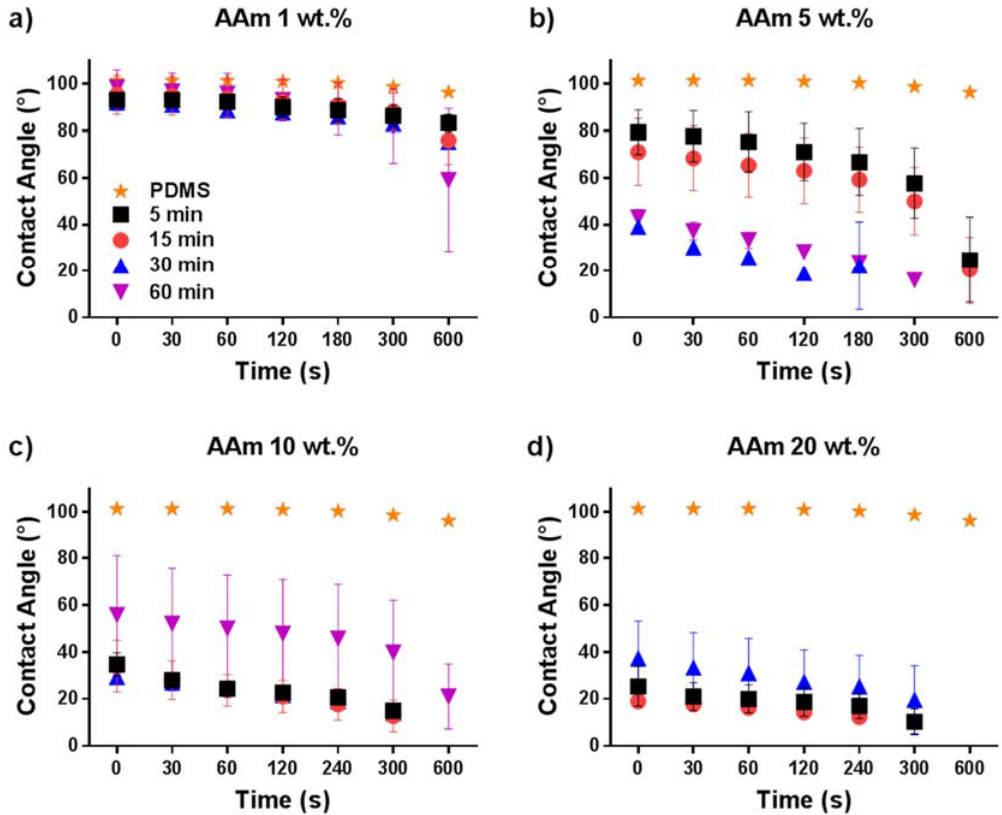
Figure 3. Contact angle measurements of PDMS surfaces coated with different concentrations of acrylamide and with various UV irradiation times: ( a ) AAm 1 wt %, ( b ) AAm 5 wt %, ( c ) AAm 10 wt % and ( d ) AAm 20 wt %.